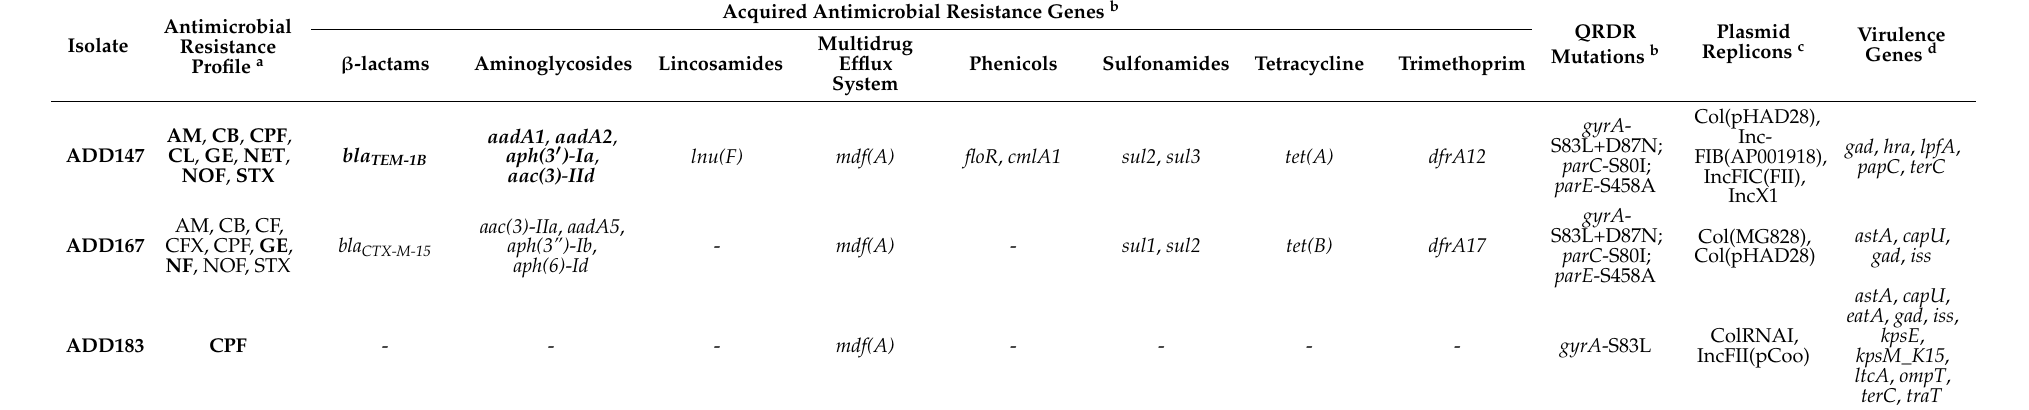
Table 2. Phenotypic and genomic profiles of antibiotic-resistant E. coli isolates from surface water of agricultural drainage in northwestern